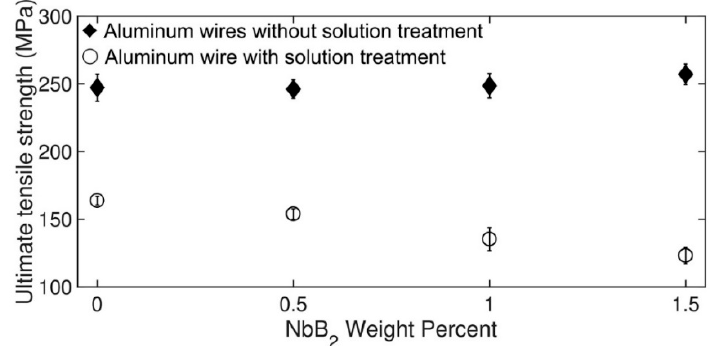
Figure 9. Measured ultimate tensile strength of the aluminum wires with and without solution treatment as a function of the content of nanoparticles added.